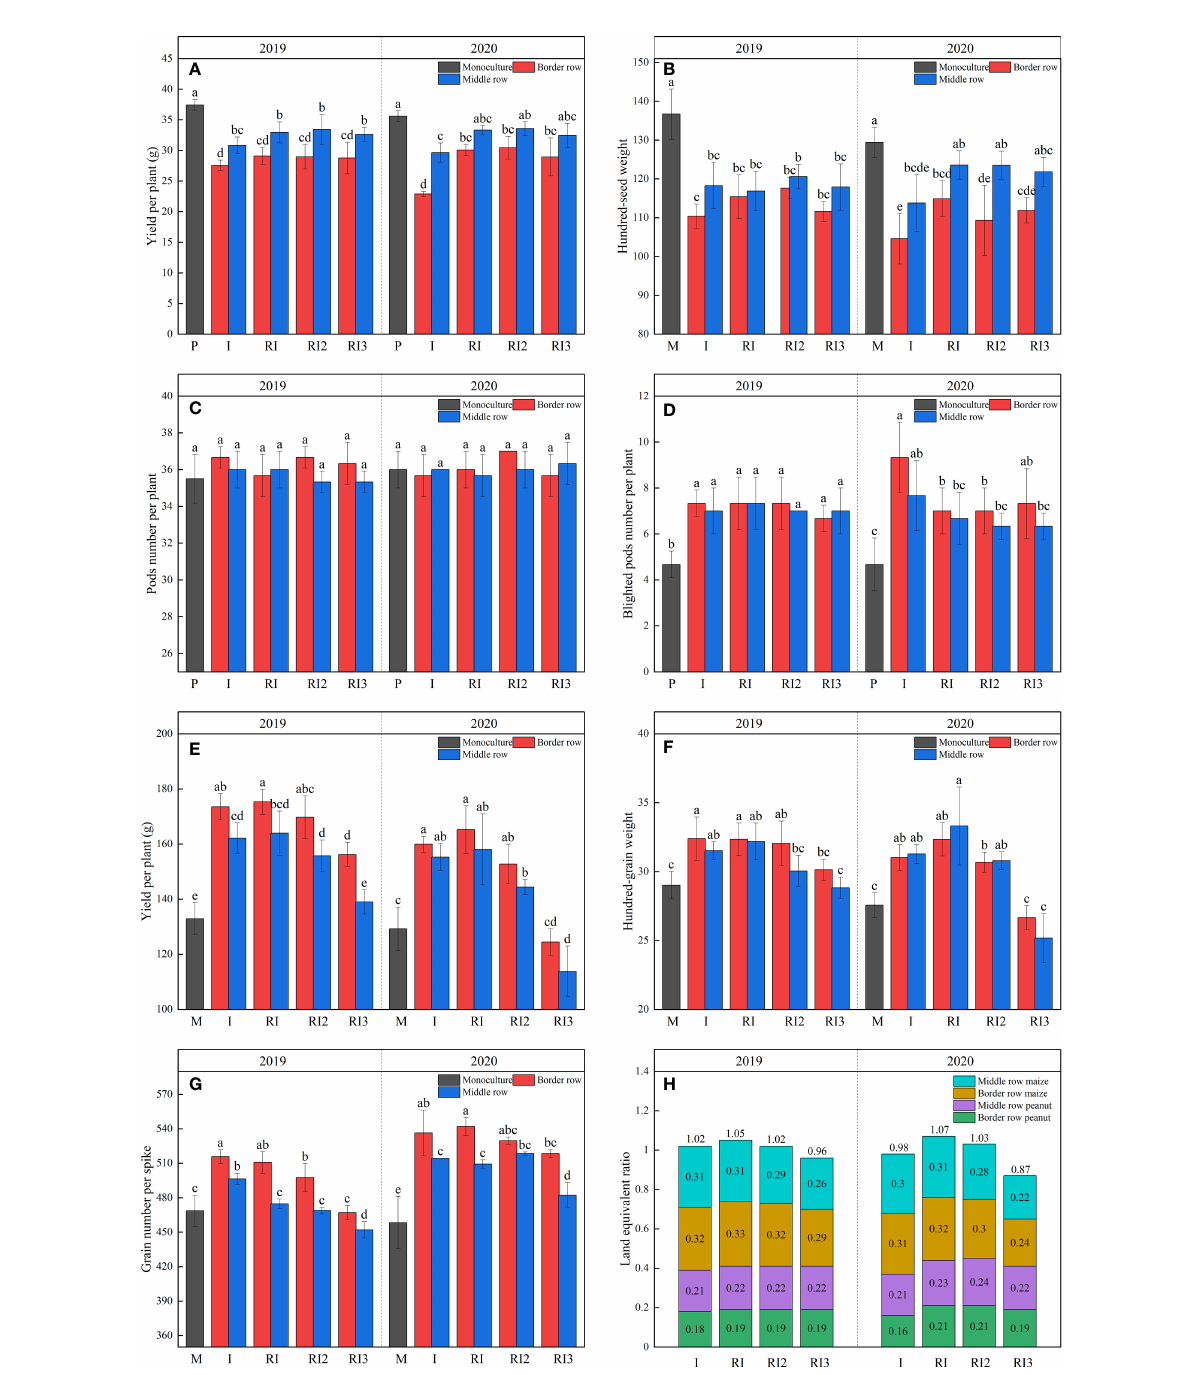
FIGURE 5 Yield, yield – related traits and land equivalent ratio. (A) , yield per plant of peanut; (B) , hundred-grain weight of peanut; (C) , full pods number per plant of peanut; (D) , blighted pods number per plant of peanut; (E) , yield per plant of maize; (F) , hundred-grain weight of maize; (G) , grain number per spike of maize; (H) land equivalent ratio. P, sole peanut; M, sole maize; I, maize – peanut intercropping; RI, maize – peanut rotation – intercropping, RI2, 20% N reduction for maize of RI; ICN3, 40% N reductions for maize of RI. Different lowercase letters represent signi fi cant